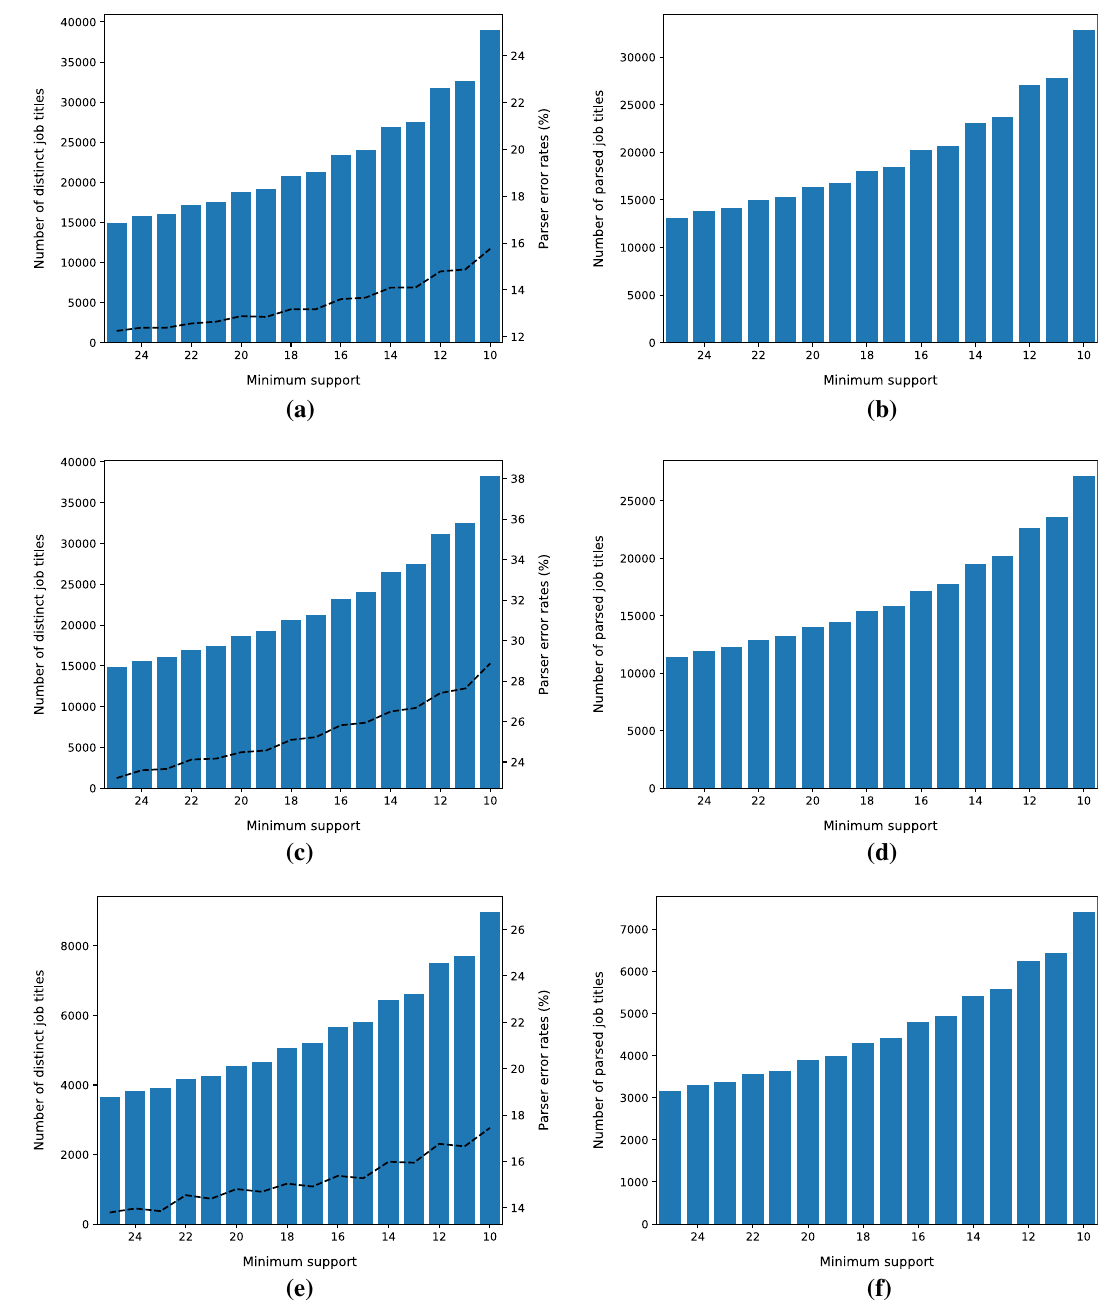
Fig. 4 Results of job title parsing. a Parsing error rates for Singapore data. b Parsed job titles for Singapore data. c Parsing error rates for Switzerland data. d Parsed job titles for Switzerland data. e Parsing error rates for Hong Kong data. f Parsed job titles for Hong Kong